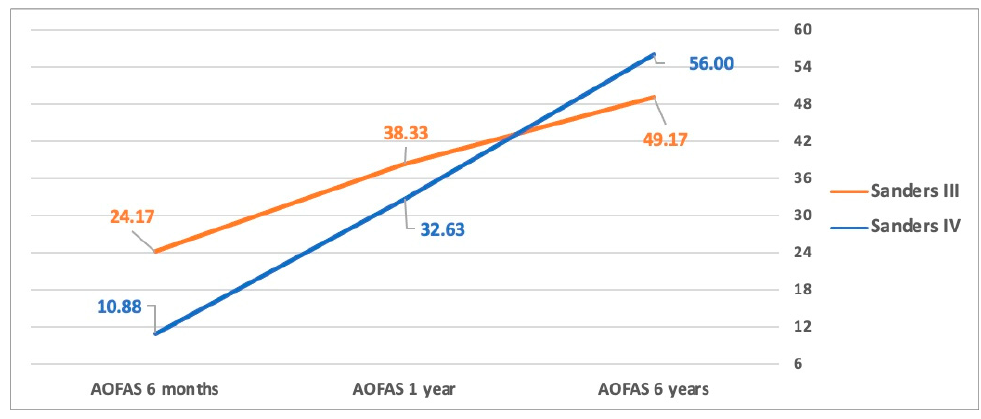
Figure 2. Physical SF-12 score between Sanders types III and IV. Similarly, the AOFAS score at six months follow-up showed better outcomes in patients affected by Sanders type III fractures. This difference gradually decreases at one-year follow-up with the tendency to inversion between the two groups, but without statistical significance. Figure 3. Mental SF-12 score between Sanders types III and IV.